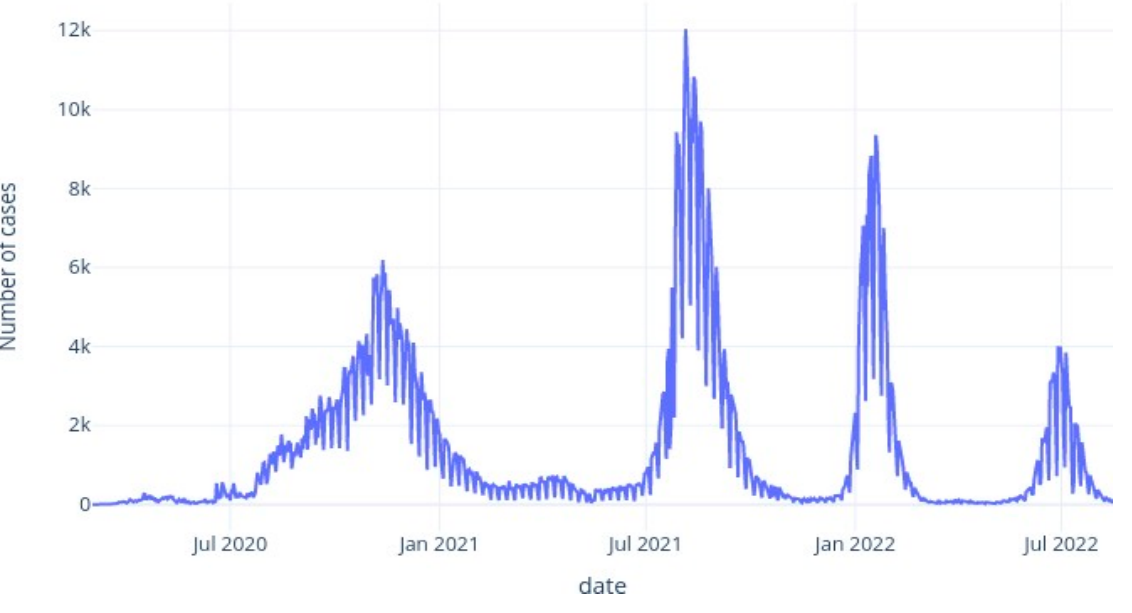
Figure 8. Morocco: COVID-19 epidemic curve.